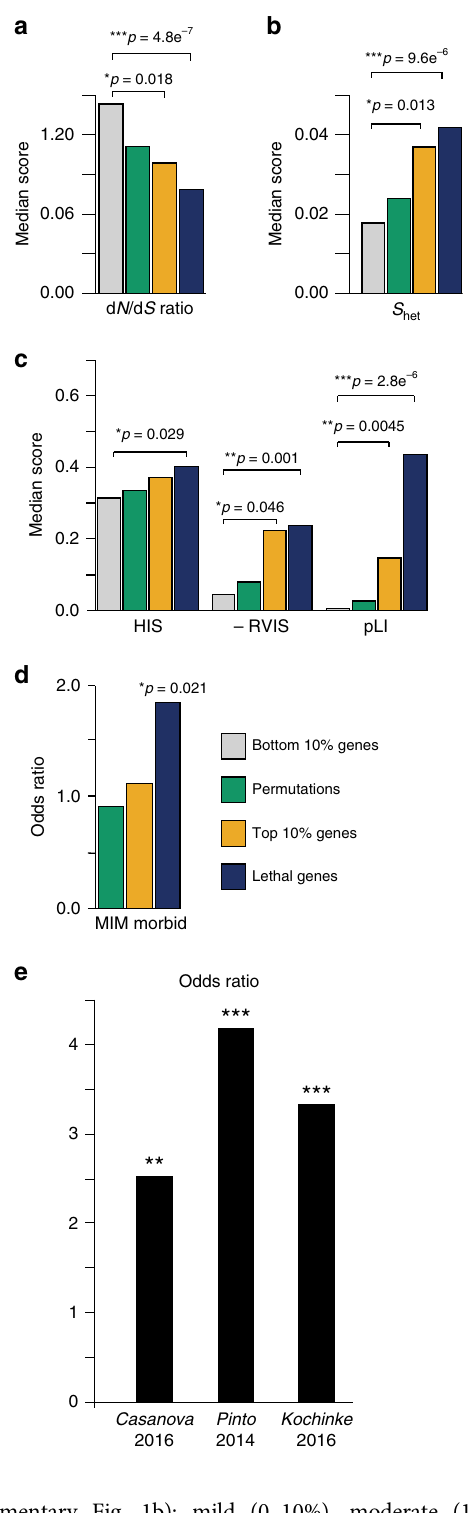
severe (20 – 40%), and very severe (>40%), the latter two groups being the most common with the maximum being 727% for the ventricles in Cep41 − / − .